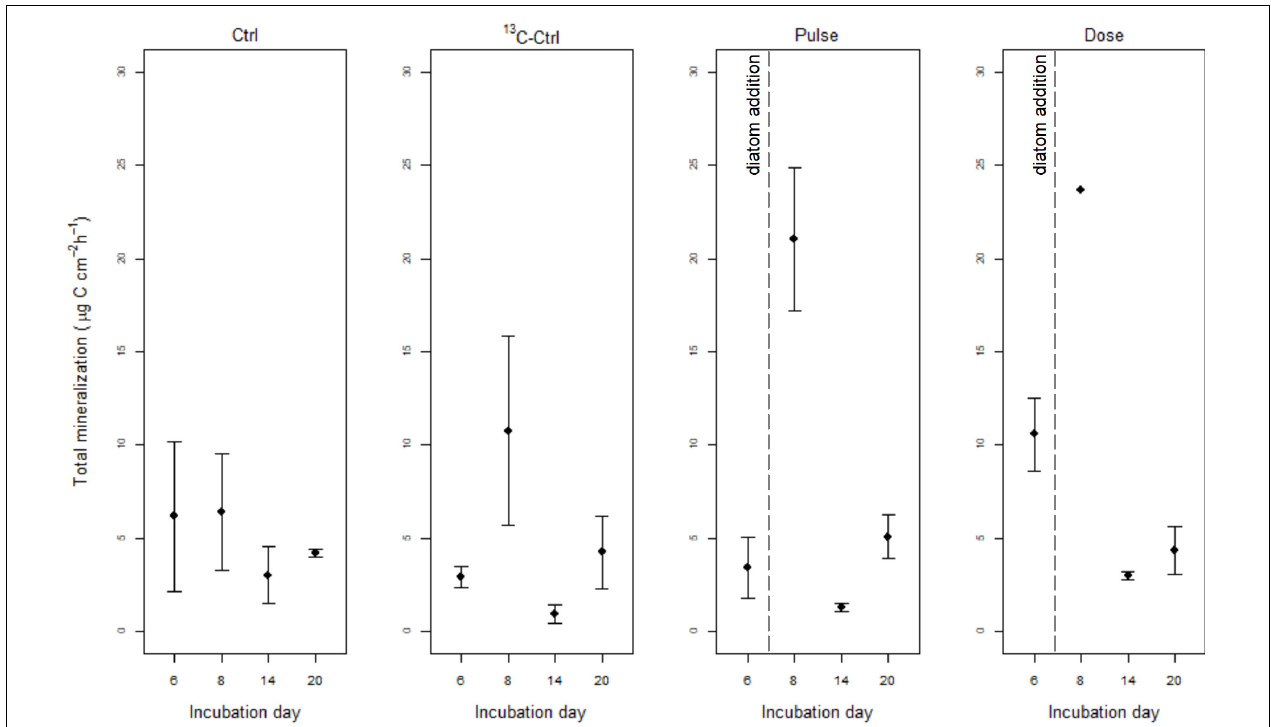
FIGURE 1 | Total mineralization rate ( µ g C cm − 2 h − 1 ) (mean ± SE) in Ctrl (no addition), 13 C-Ctrl ( 13 C-wheat only), Pulse ( 13 C-wheat + diatoms pulse), and Dose ( 13 C-wheat + repeated addition of low doses of diatoms) treatments. Note that diatom detritus in Pulse and Dose treatments was added on day 7.